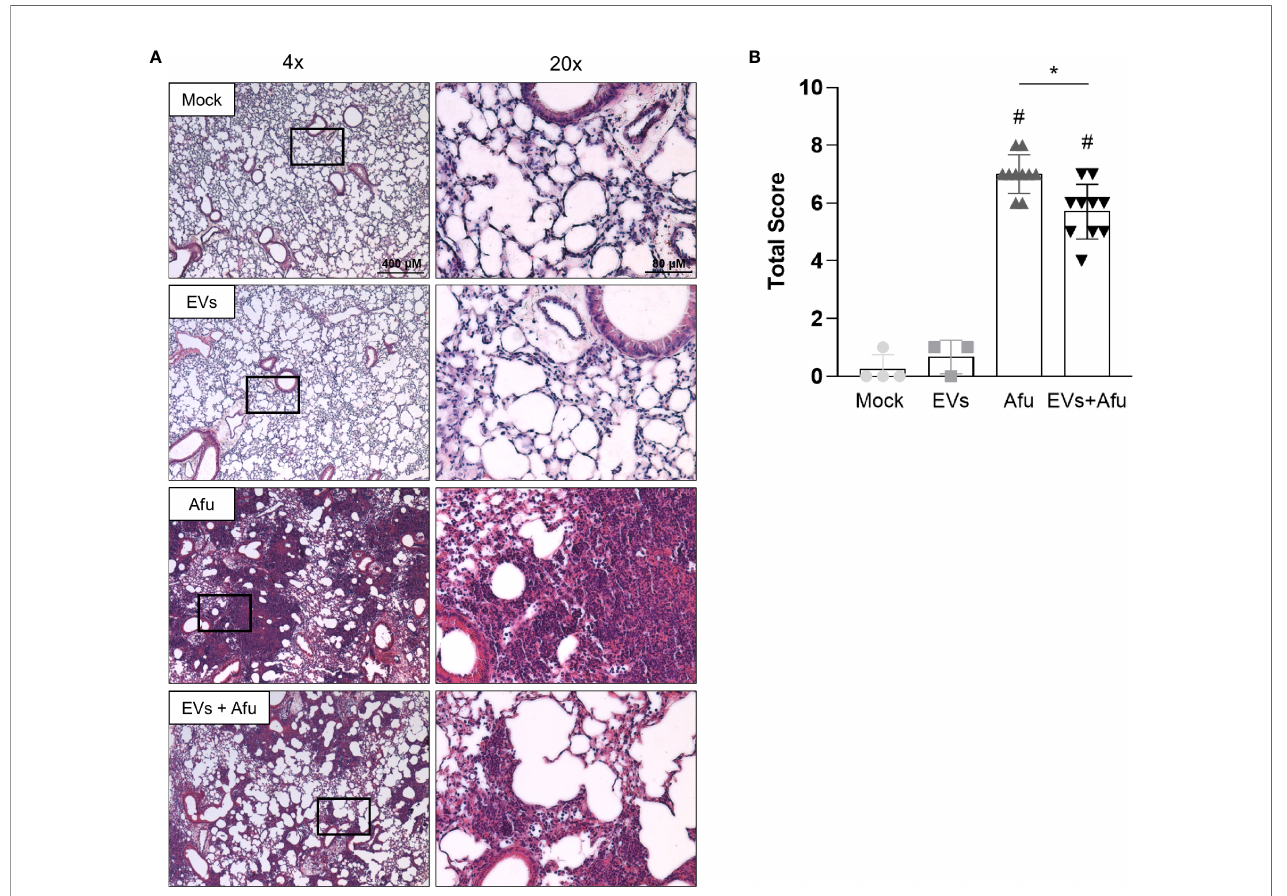
FIGURE 4 | Immunization with A fumigatus EVs attenuates the lung damage post infection. C57BL/6 mice were immunized twice with 2.2 × 10 9 EVs and challenged with 1 × 10 8 A. fumigatus conidia. Representative slides of hematoxylin and eosin (H&E) stained lungs are shown (A) . Scale bars = 400 µm (low magni fi cation) and 80 µm (high magni fi cation). Right slides are higher magni fi cations (20x) of the selected areas (boxes) in left slides (4x). Histopathological score evaluated airway, vascular, and parenchymal in fl ammation, neutrophilic in fi ltration, and epithelial injury (B) . Data are mean ± SD of N = 5-6 animals per group. # /*P < 0.05 when compared to the Mock group ( # ) or as indicated (*), as determined by One Way-ANOVA. Data are representative of two